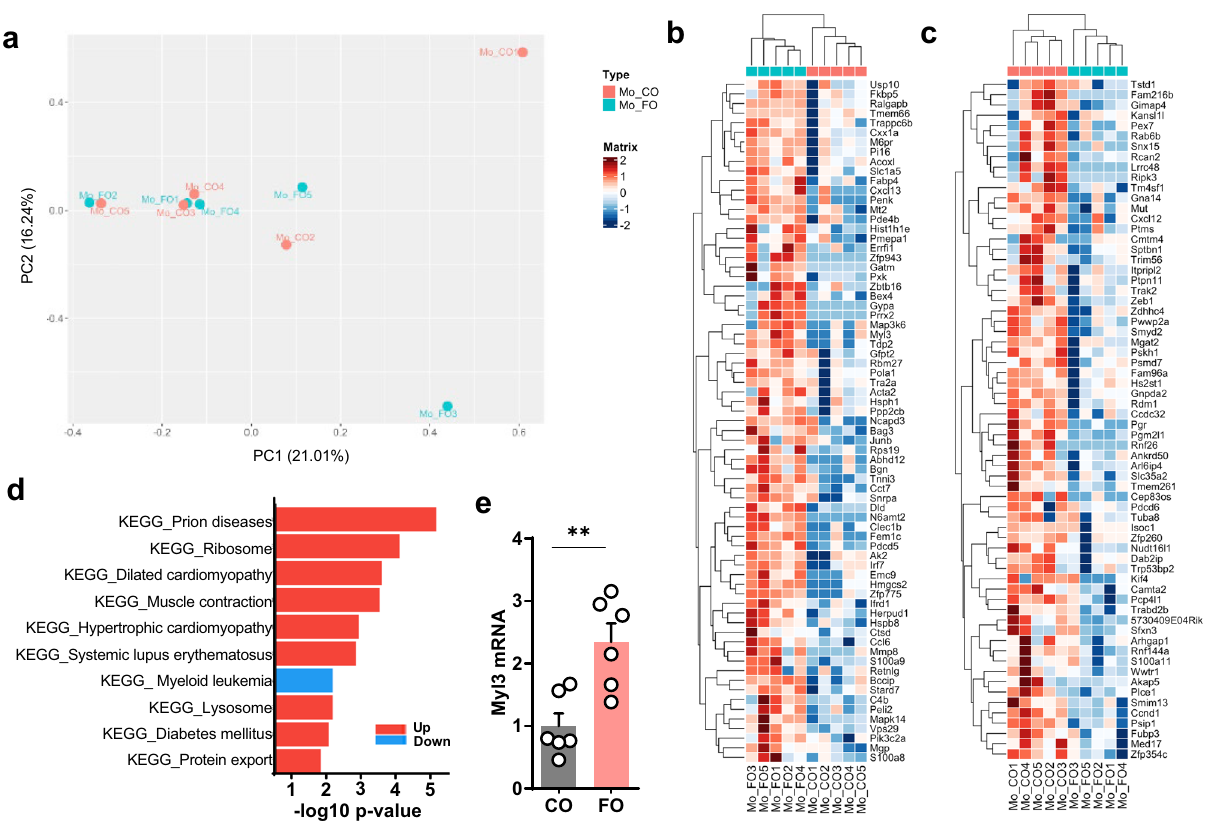
Figure 3. Lung transcriptomes from mice fed with n-3-PUFA diet. Clustering of lung transcriptomes and differential gene expression from FO or CO fed mice. RNA-sequencing was performed on RNA isolated from lung tissue after 8 weeks. ( a ) Principal component analysis (PCA) from whole lung. Differential gene expression analysis, comparison is of FO and CO groups. ( b ) Genes relatively upregulated in the FO group. ( c ) Genes relatively downregulated in the FO group. ( d ) Summary of KEGG pathways associated with differentially expressed genes (p < 0.05), comparison is of FO vs CO groups with upregulated in red and downregulated pathways in blue. ( e ) Expression of Myl3 in lungs from mice from independent experiments by Real-Time PCR. **p < 0.001 (unpaired